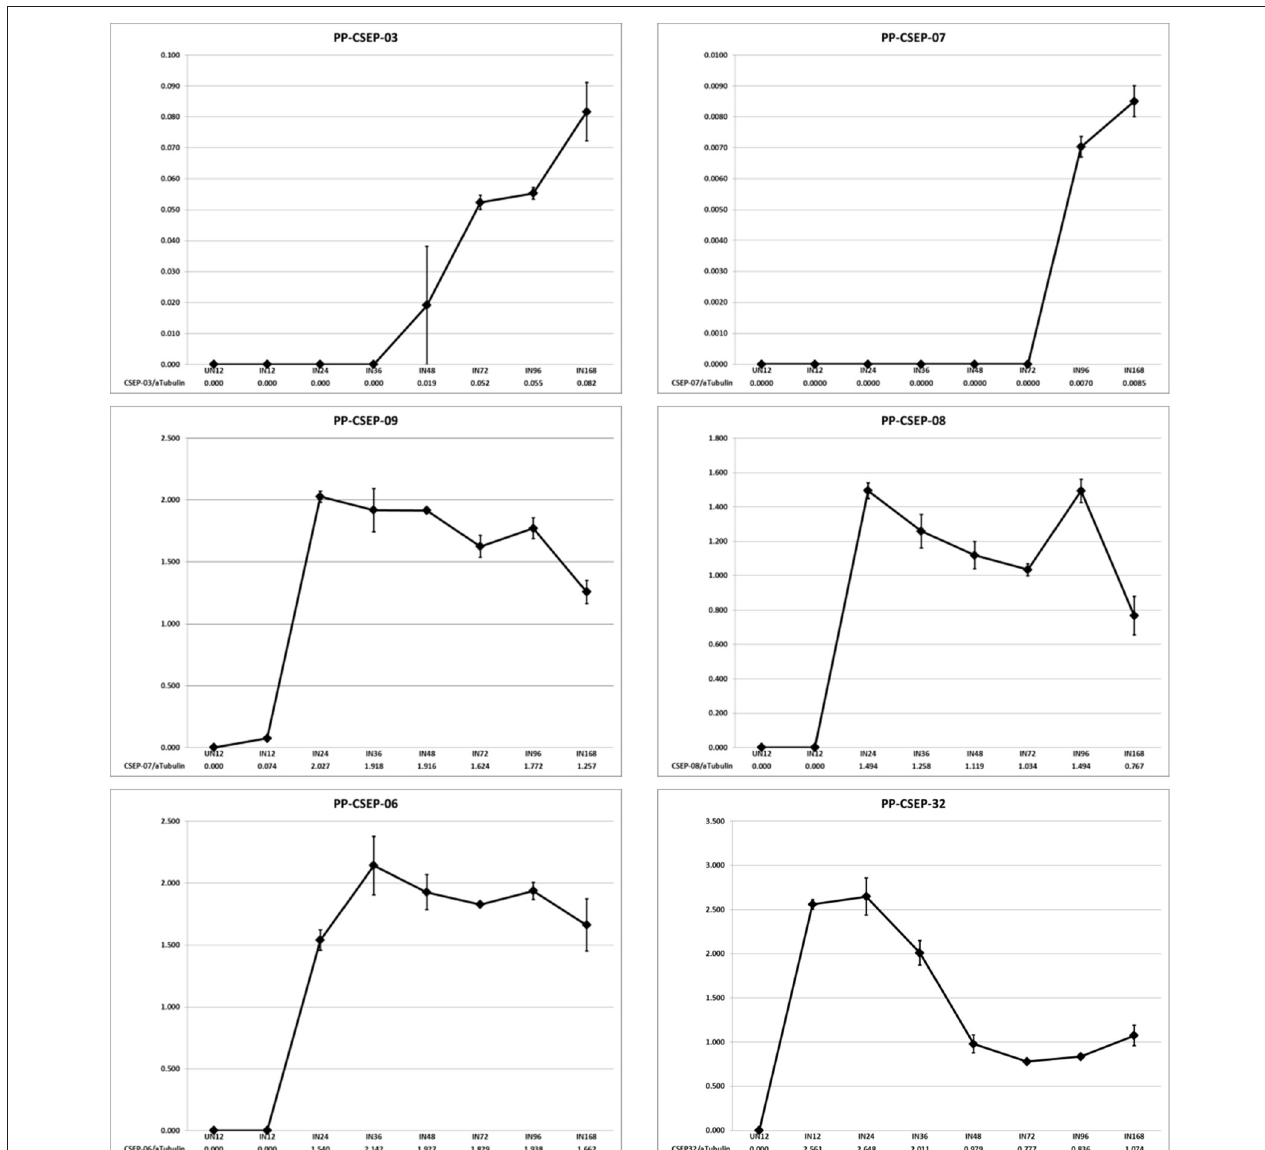
FIGURE 2 | Expression profiles of selected P. pachyrhizi candidate effectors. RNA was harvested from soybean leaves at 12, 24, 36, 48, 72, 96, and 168h after spray inoculation and transcript levels were quantified using qRT-PCR. RNA was also harvested from uninoculated tissue as a negative control (UN12). Error bars are standard error of the mean of three biological